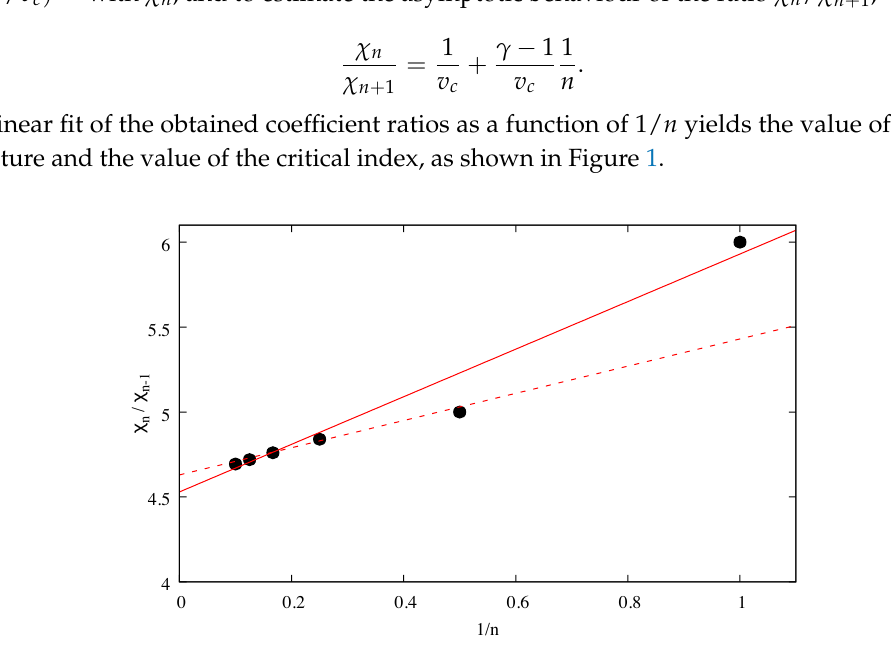
Figure 1. Plot of Equation (3). Black dots are the ratios of the expansion coefficients, while the red solid line is a linear fit. The intercept provides information about T c , while the slope is related to γ . Results are in good accordance with the results found in the literature. The red dashed line is a linear fit through the points omitting the one at n = 1 but it leads to results for T c and γ that deviate from the correct